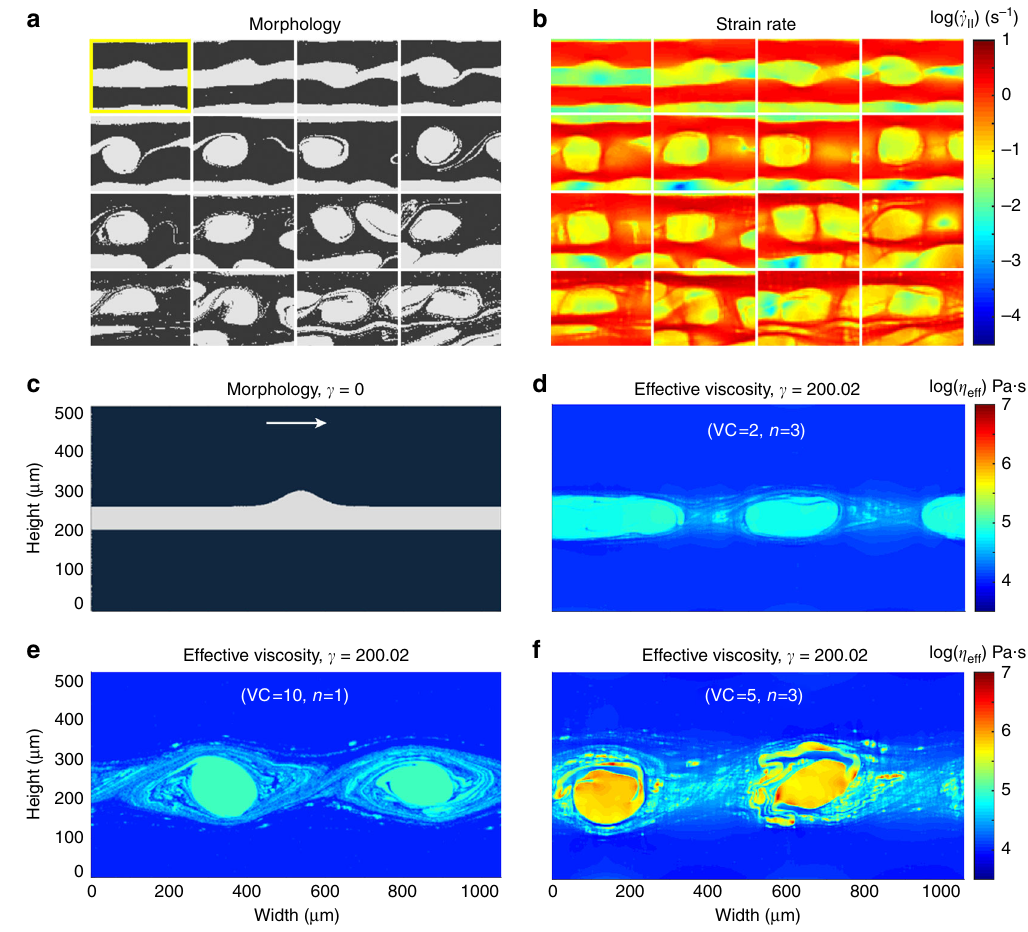
Fig. 4 Evolution of a perturbation with shear. a , b The perturbation in the initial multilayer cell marked in the yellow box (Fig. 3a), but for a simulation with (VC = 5, n = 3). The shear increases from top-left to bottom-right. a Morphology map. b Strain rate map. The selected snapshots are obtained by tracking the feature in the simulation cell using an image correlation technique. See Supplementary Movie 6 for the dynamical evolutions of morphology and strain rate. c – f Simulation of a single layer with a symmetrical perturbation. c The computational cell showing the initial layer with higher characteristic viscosity (white) embedded within a matrix with lower characteristic viscosity (black). The arrow shows the direction of shear. d – f Effective viscosity ( η eff ) maps at shear strain γ = 200.02 for three cases as indicated. Note that the overall effective viscosity contrast between the two phases increases from d –